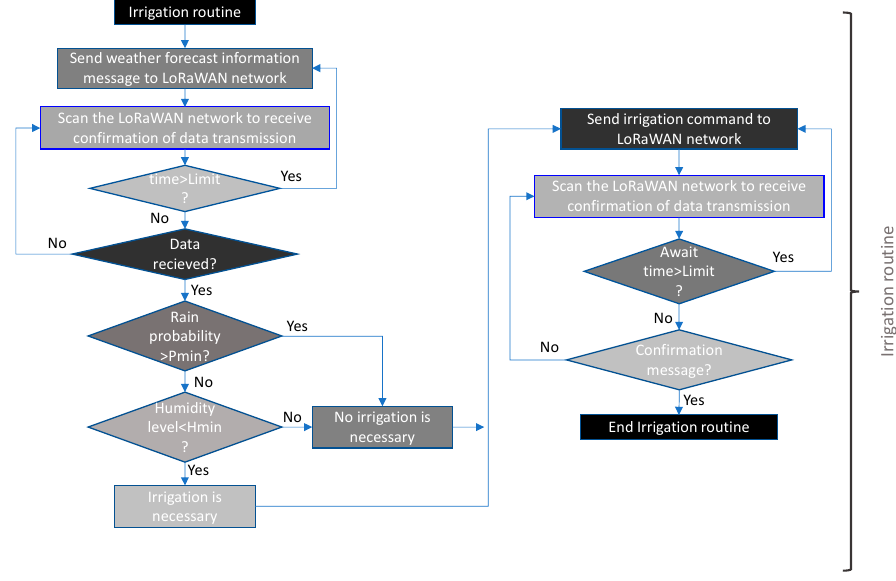
Figure 14. Flow chart of the irrigation routine for THMDL.